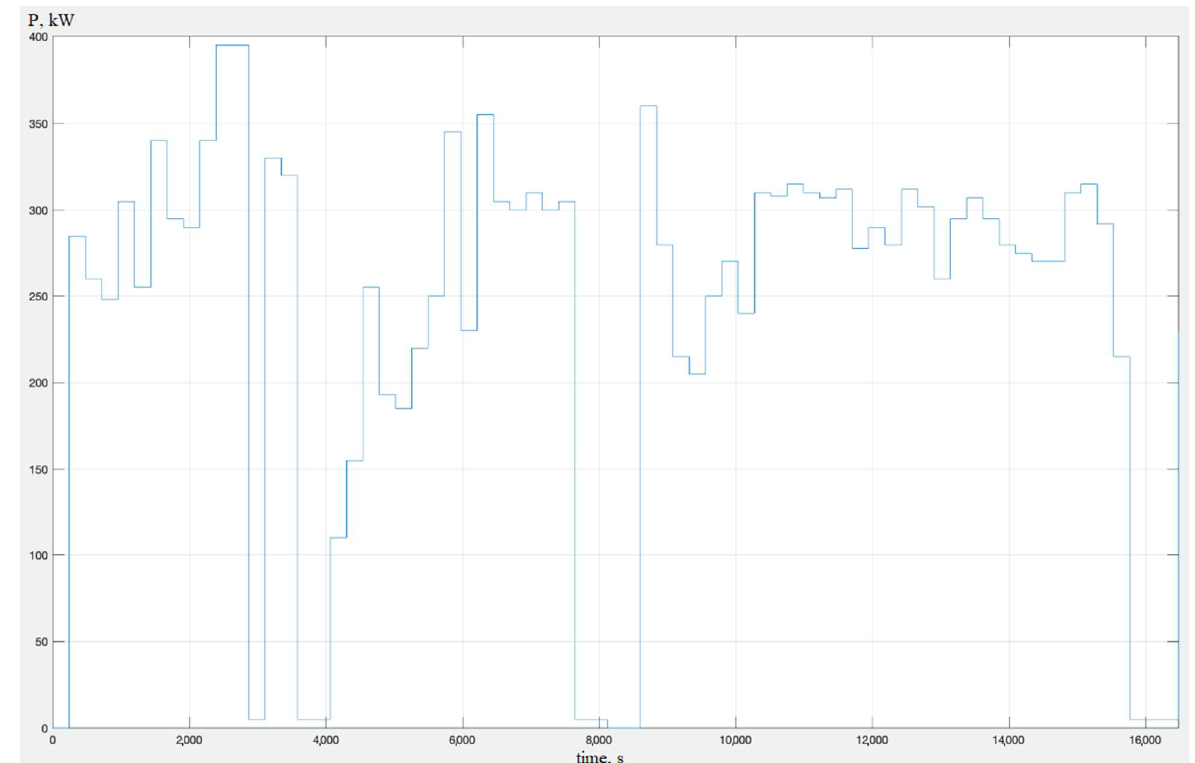
Electricity 2022 , 3 , FOR PEER REVIEW Figure 1. Fragment of the curve of active power consumption without a VFD. Figure 3. Fragment of the curve of active power consumption without a VFD.